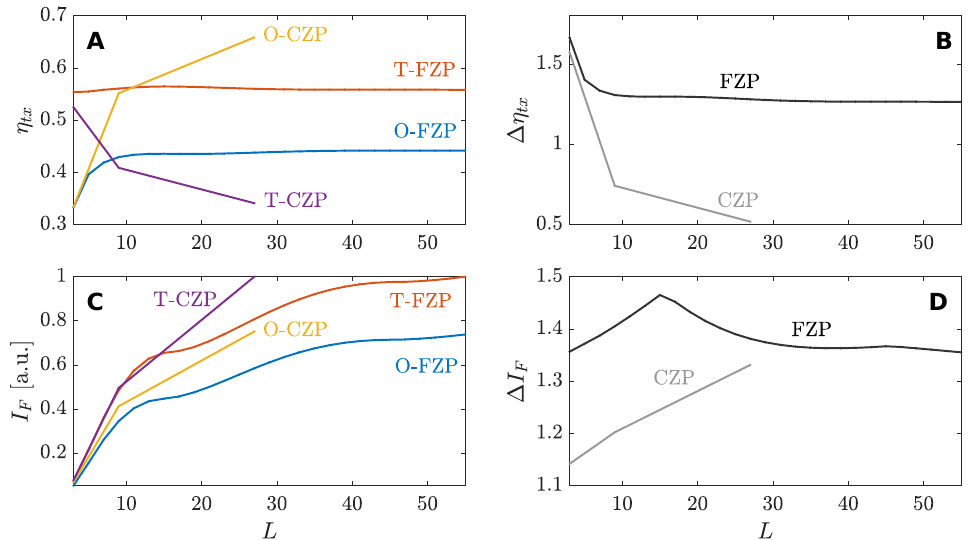
Figure 3. Simulation results of the focusing efficiency for the two considered lens types. ( A ) Transmis- sion efficiency, ( B ) transmission enhancement factor, ( C ) normalized focal intensities, and ( D ) focusing enhancement factor. All results are given as a function of the binary sequence